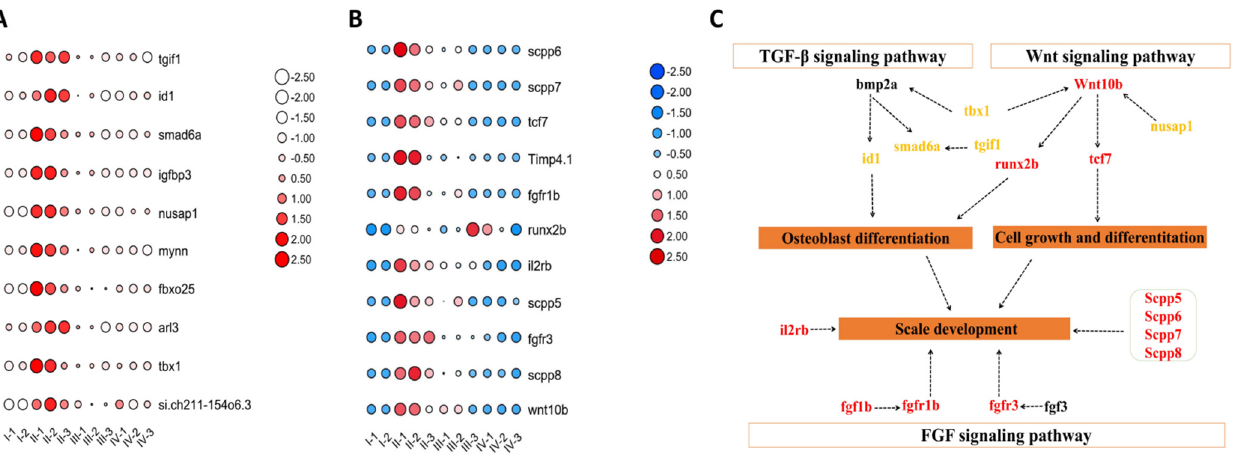
Figure 5. ( A ) Heat map of 10 hub-genes. ( B ) Heat maps of 11 important genes screened by traditional transcriptome analysis. ( C ) Three important signal pathways obtained by comprehensive analysis.